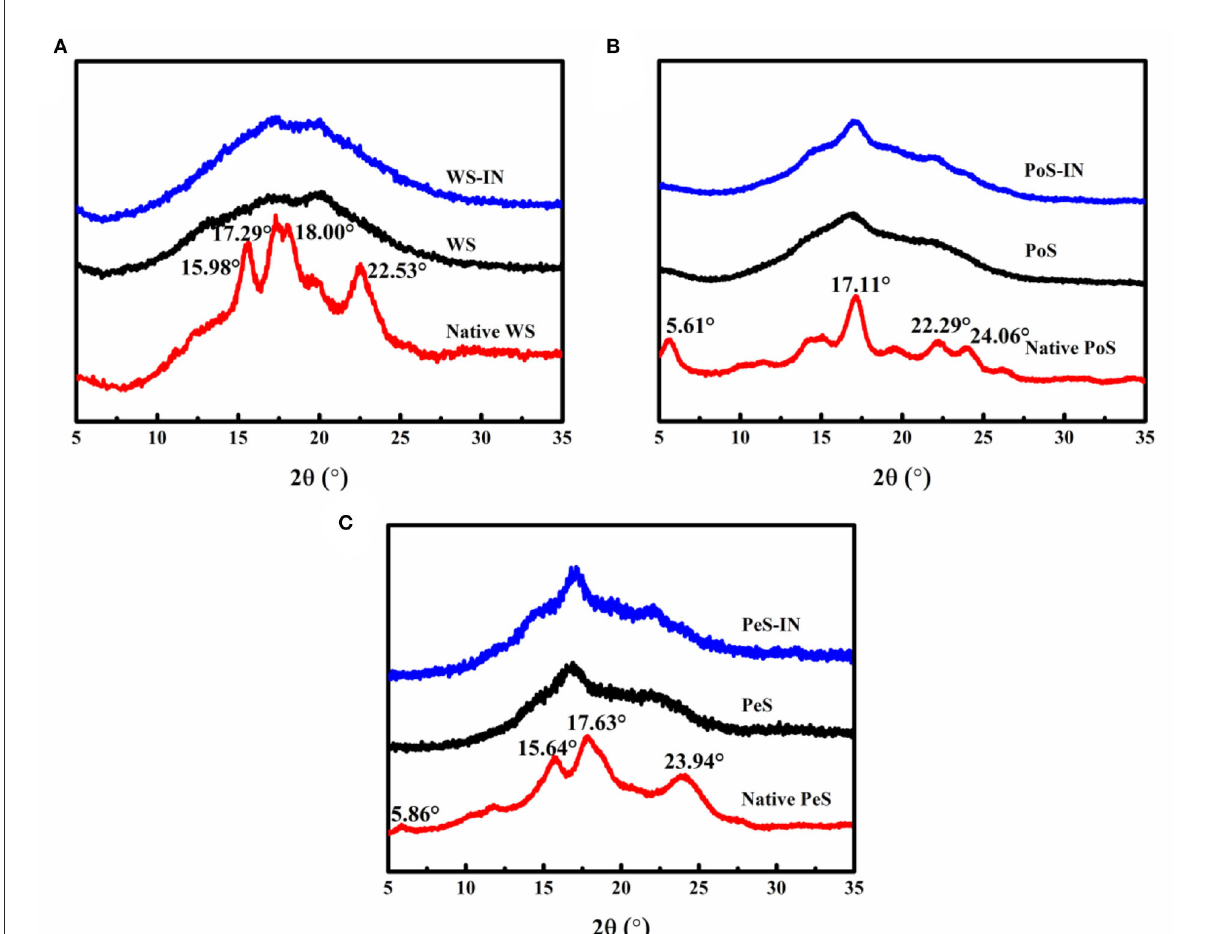
FIGURE1 The XRD patterns of the different crystalline starch and inulin-starch compound systems: (A) wheat starch, (B) potato starch, (C) pea